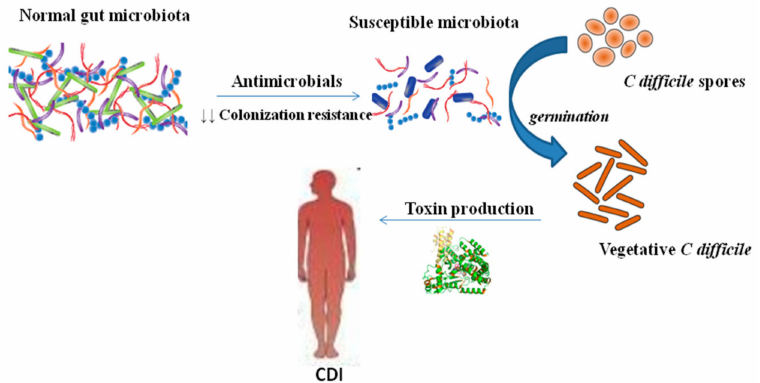
Figure 1. Gut microbiota and Clostridioides di ffi cile infection (CDI). Gut microbiota has central role to C. di ffi cile infection pathogenesis. ↓